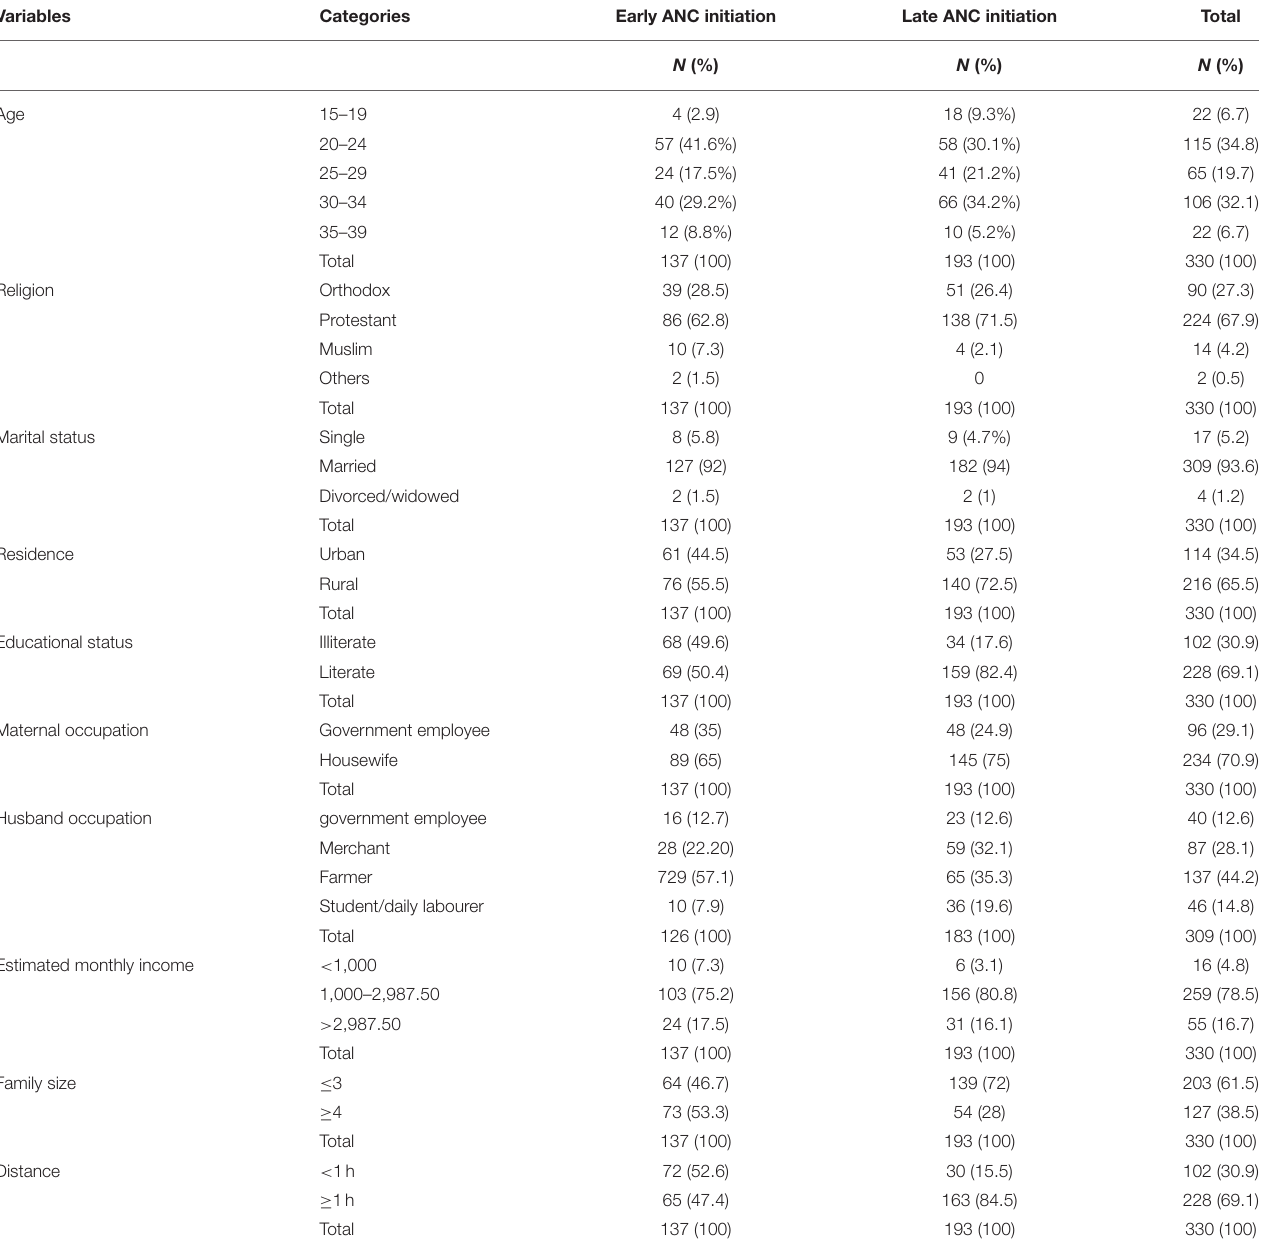
TABLE 1 | Socio-demographic characteristics of pregnant mothers who were attending ANC in the Gedo general Hospital, West Shoa zone, Oromia region, Ethiopia ( n =